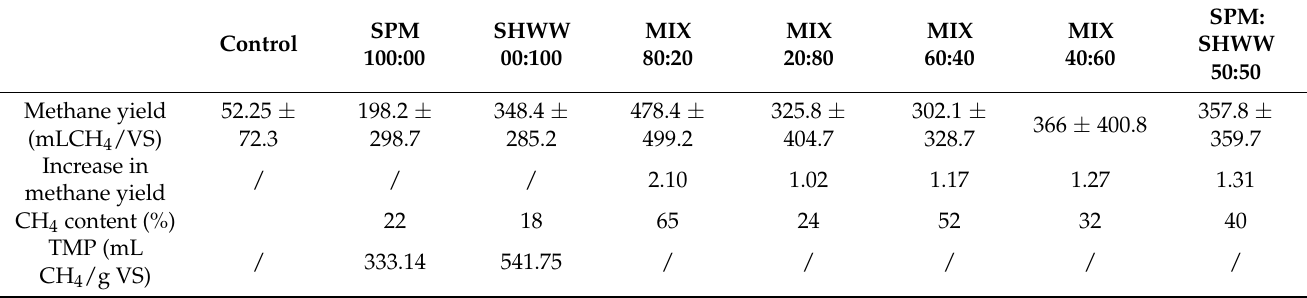
Table 5. BMP of long-term mesophilic batch reactors with respective standard deviation